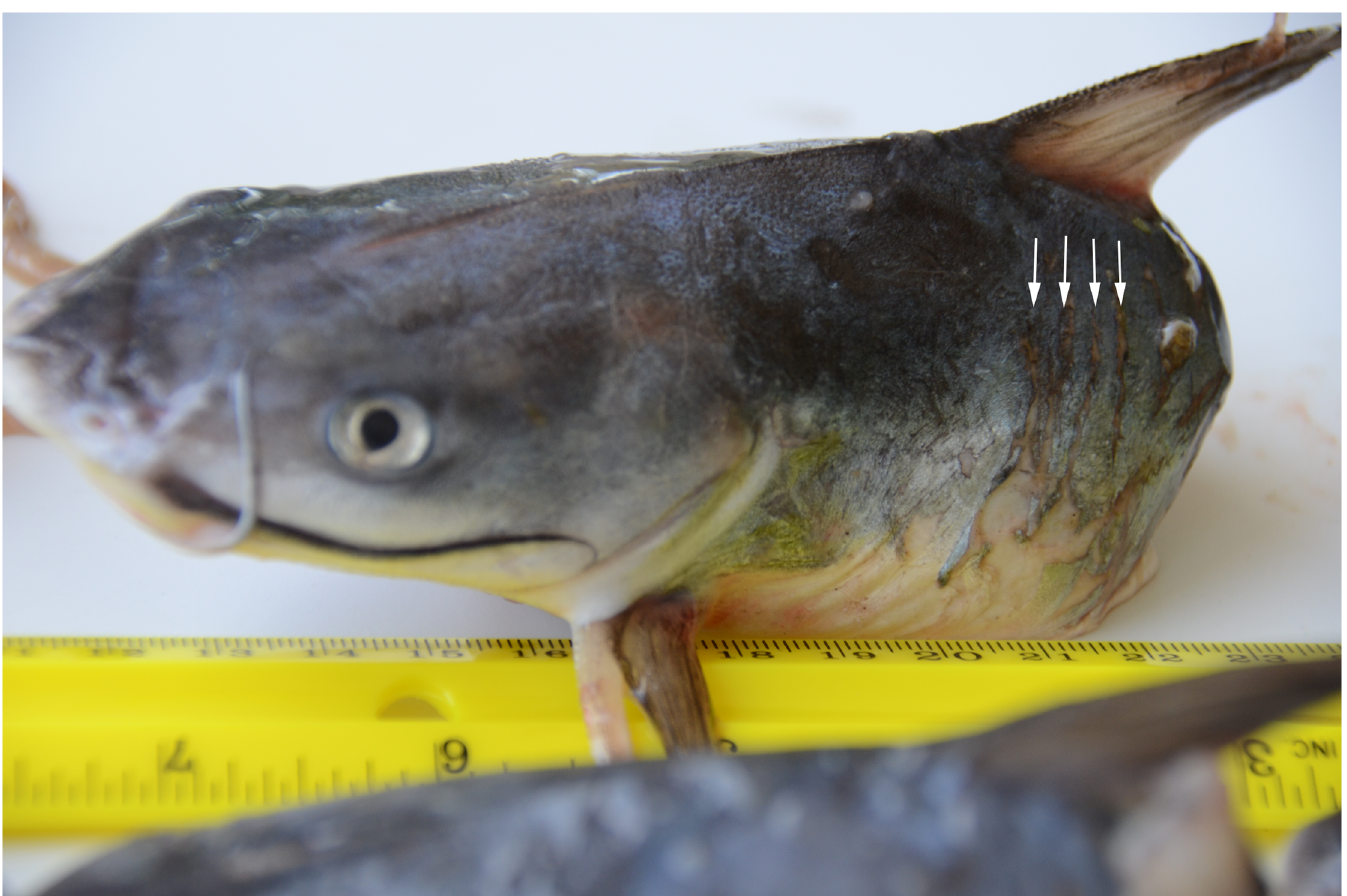
Fig 4. Severedcatfish head from the 7 May 2015 sighting (MSS). Linear epidermal tears at right are typical of dolphinrake marks and are near the point of amputation in each SCH.